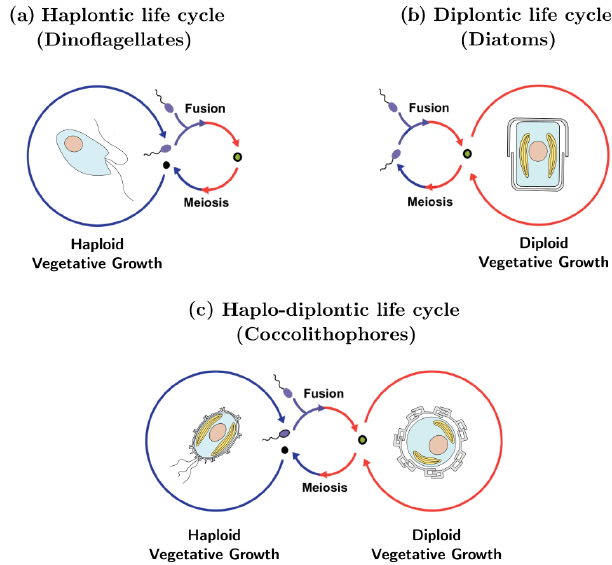
Figure 1. Life cycle strategies of phytoplankton: (a) dinoflagellates tend to utilize a haplontic life cycle, (b) diatoms tend to utilize a diplontic life cycle, and (c) coccolithophores tend to utilize a haplo- diplontic life cycle. Note that not all coccolithophores calcify in their haploid